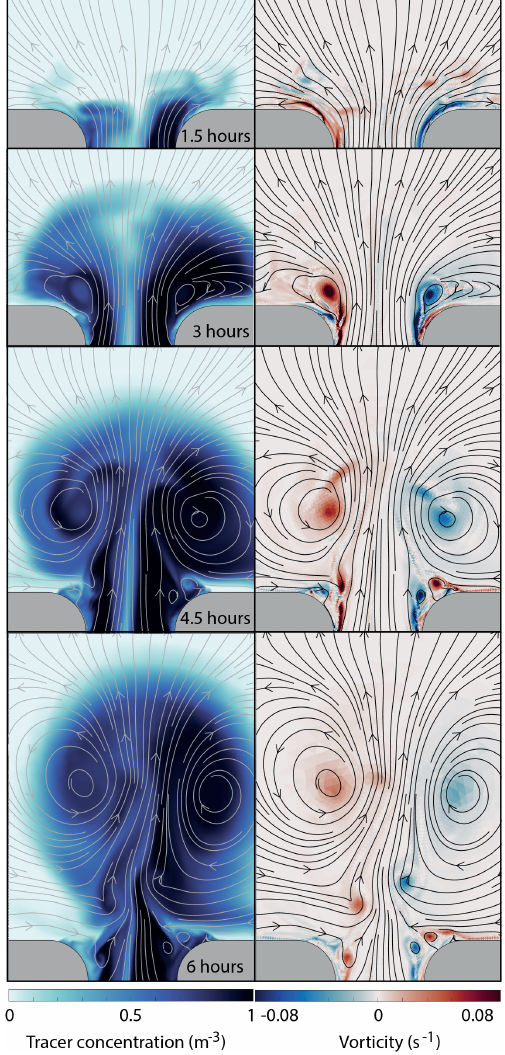
Figure 6. The temporal tracer and vorticity fields, with the corre- sponding stream function, are displayed for a 4.5km wide and 4km long strait in the left and right panel, respectively. The experiment is forced with a tidal wave of amplitude A t = 1m. The upper, mid- dle, and lower panels show a snapshot in time of the tracer and the vorticity fields at 1.5, 3, and 4.5h after slack tide,